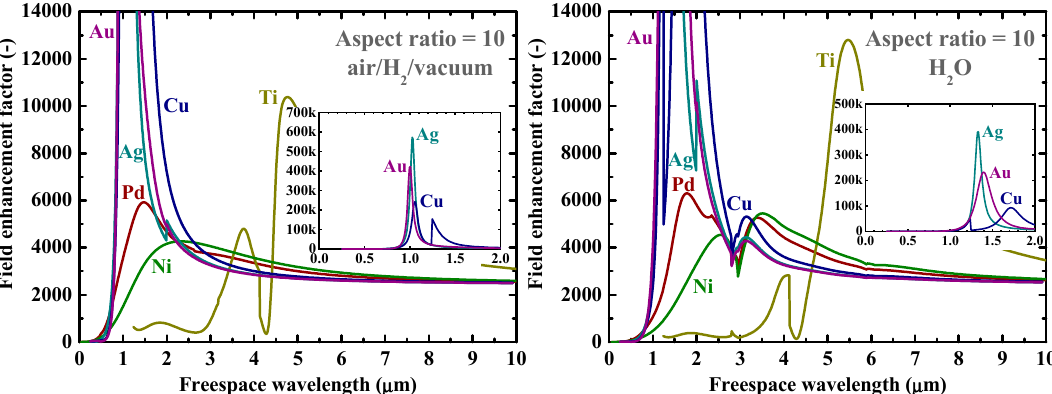
Figure 3. Calculated electromagnetic field enhancement factors at the tips of spheroidal nanoparticles of Au, Ag, Cu, Pd, Ti, and Ni with an aspect ratio of 3 in ( left ) air/H 2 /vacuum and ( right ) H 2 O. The insets are the clarified plots for Au, Ag, and Cu.